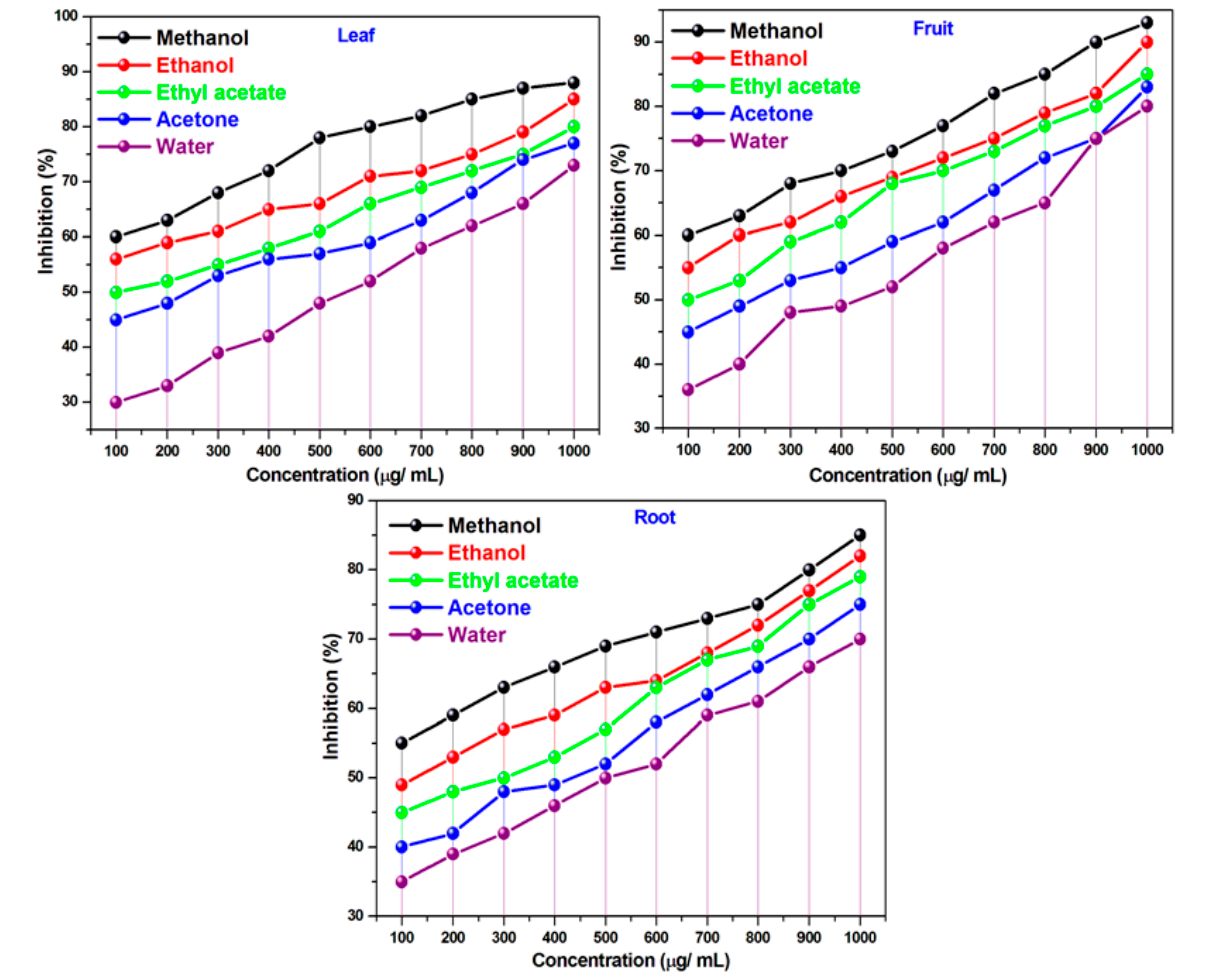
Figure 2. Nitric oxide assay of P. ginseng